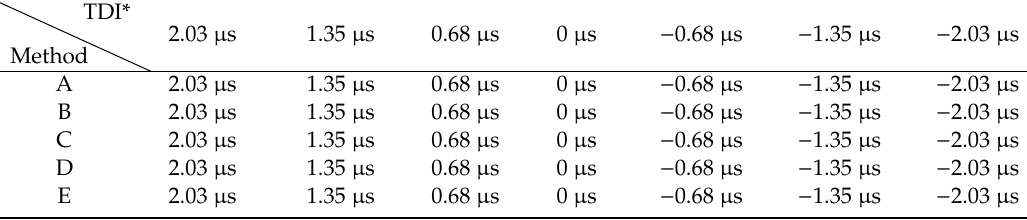
Table 3. The time di ff erence results for the five algorithms under ideal conditions. MethodTDI*